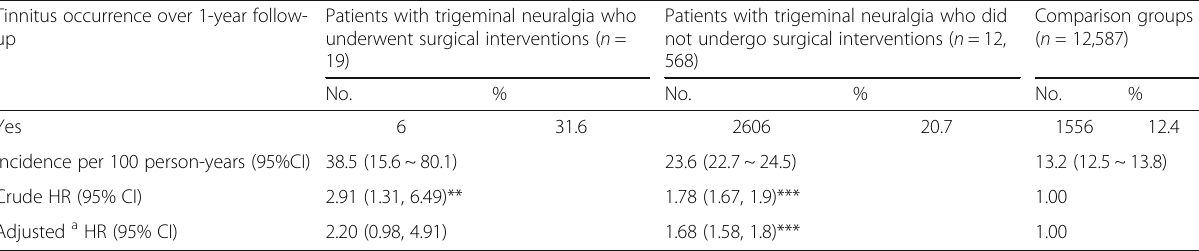
Table 3 Incidence rate, crude and adjusted hazard ratios for tinnitus among the sampled patients stratified by surgical intervention Tinnitus occurrence over 1-year follow- up